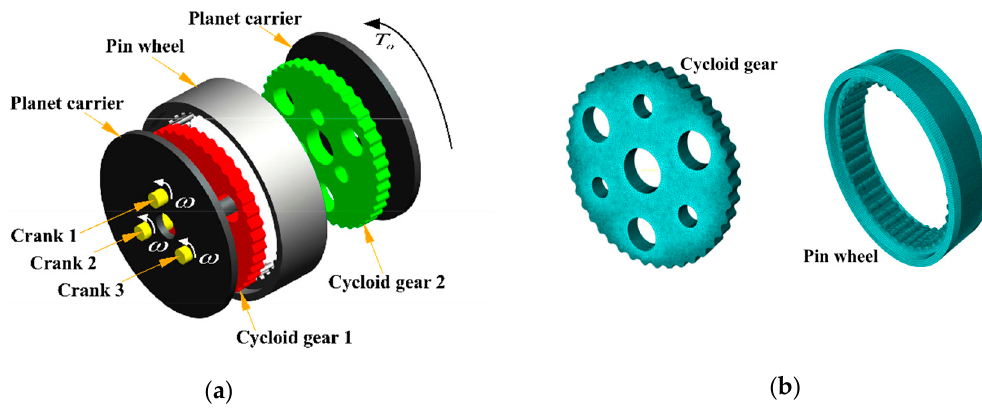
Figure 5. Finite element (FE) model of RV reducer: ( a ) exploded view and ( b ) mesh calculation.